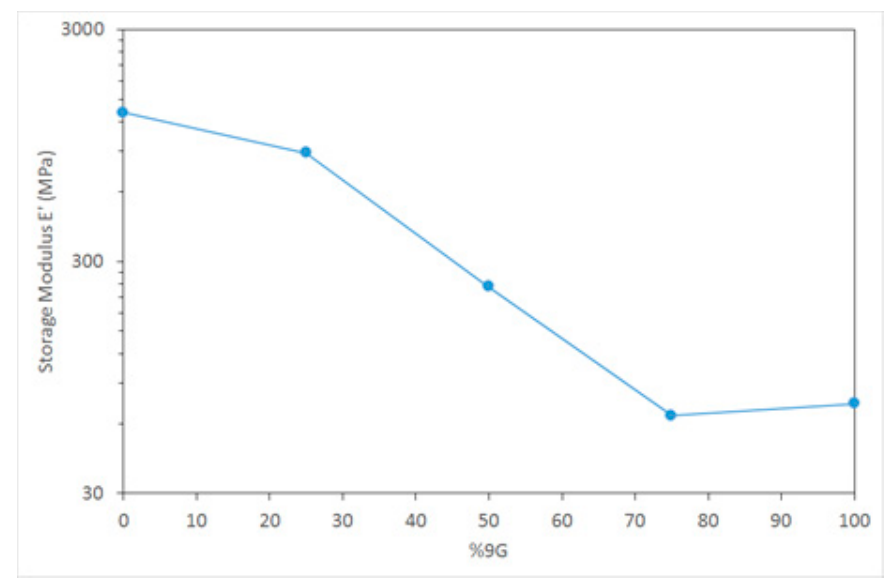
Figure 6. DMTA storage modulus for postcured samples at 25 °C.